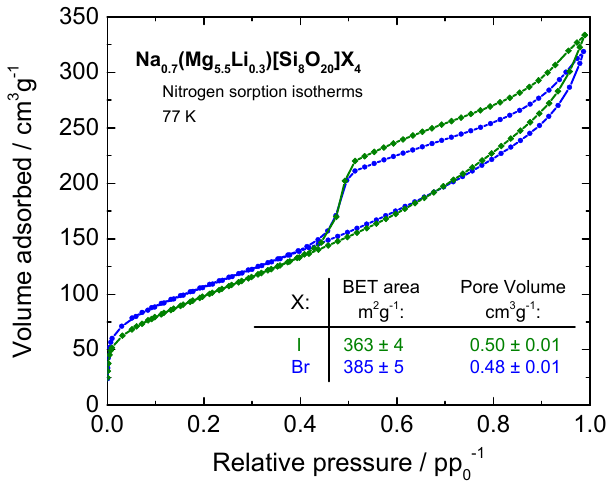
Figure 5. The nitrogen sorption isotherms of bromohectorite and iodohectorite.